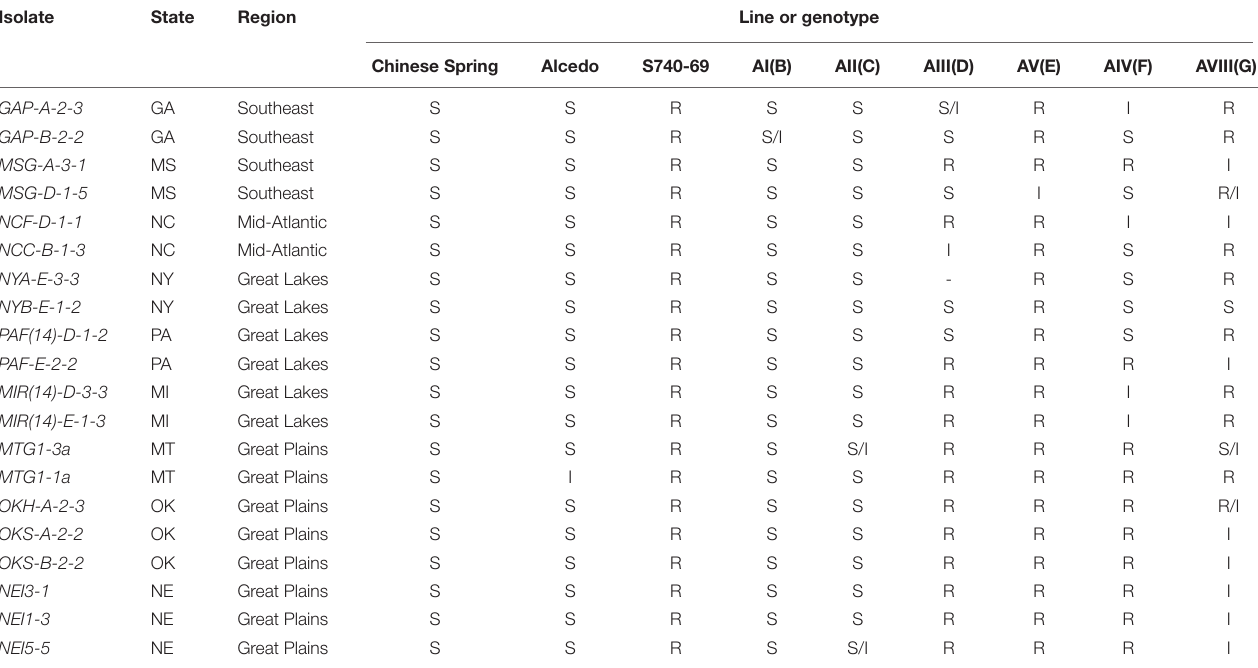
TABLE 5 | Reactions of six Alcedo- Aegilops markgrafii addition lines, their parents, and the Chinese Spring check when tested with 20 isolates of powdery mildew pathogen collected from nine states and four regions of the United States.